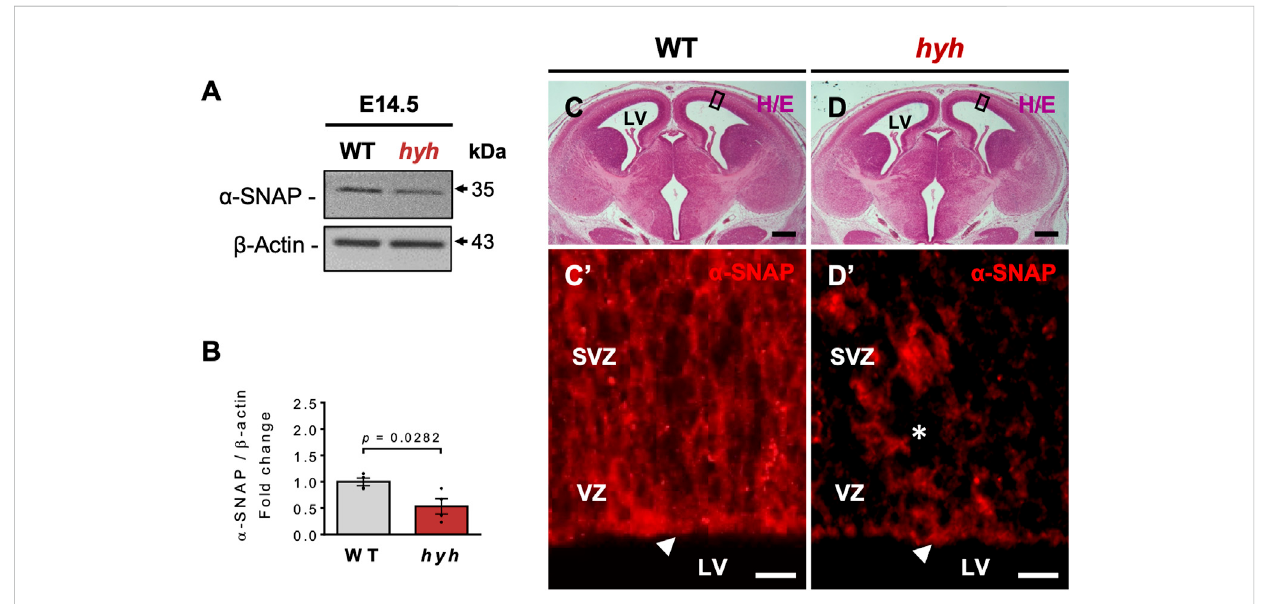
FIGURE 1 α -SNAP expression patternand consequences ofhyh(M105I)mutation. (A) .WesternblotanalysisofWT andhyhtelencephaliclysates atE14.5 using antibodies against α -SNAP. β -actin was used as loading control. (B) . Densitometric analysis of Western blot in (A) . The data is presented as mean ± SEM, n=4.Differenceswith p < 0.05wereconsideredsigni fi cant(Student ’ st-testwithWelch ’ scorrection). (C,D) .Representativebraincoronalsectionsstained withhematoxylin/eosin(H/E)fromWT (C) andmutantmice (D) atE14.5.Theblackboxesindicatetheareadisplayedwithhighermagni fi cationin (C ’ ) and (D ’ ) . (C ’ ,D ’ ) . Immunostaining for α -SNAP in the ventricular (VZ) and subventricular zone (SVZ). Note that hyh mice showed a reduction in α -SNAP immunoreactivity in the apical region of the VZ (white arrowheads) and the SVZ (asterisk). LV: Lateral Ventricles. Scale Bars: D and E = 300 µm; D ’ and E ’ = 10